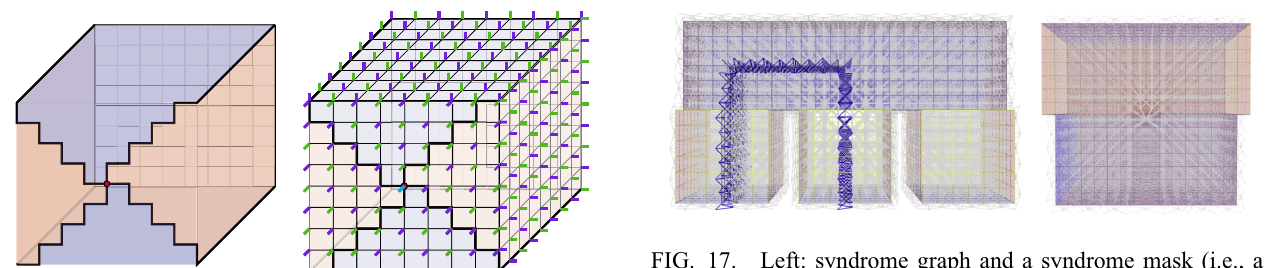
FIG. 17. Left: syndrome graph and a syndrome mask (i.e., a logical membrane projected onto the syndrome graph) for lattice surgery. The three input ports are displayed at the front along the FIG. 16. Noisy magic state preparation block. Left: noisy bottom of the diagram. Right: syndrome graph for the phase magic state preparation can be regarded as a fault-tolerant instru- ment taking a distance-1 code state (i.e., an unencoded state) to a distance- d code state. The block produces (on the rear port) an encoded version of an arbitrary input qubit (on the front center). The depth is exaggerated for the purpose of illustration. Right: the six-ring fusion network measurement pattern for the block (defined here by considering the fusion graph as the 1-skeleton of the dual of the block template). Individual qubits belonging to resource states on the boundary are measured in the X ( Z ) basis as accordingly depicted by purple (green) edges. To pre- √ 2 on the output, the pare an encoded | T (cid:3) = ( | 0 (cid:3) ± e i π/ 4 | 1 (cid:3) )/ qubit belonging to the central resource state is measured in the ( X + Y ) basis; the ± sign is determined by the measurement 1 2 outcomes.